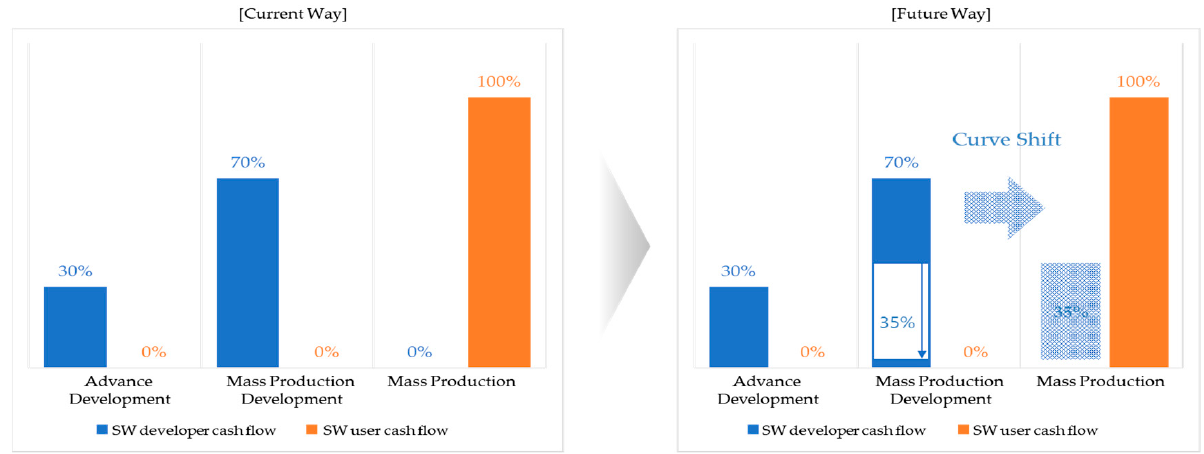
Figure 8. Software billing concept.